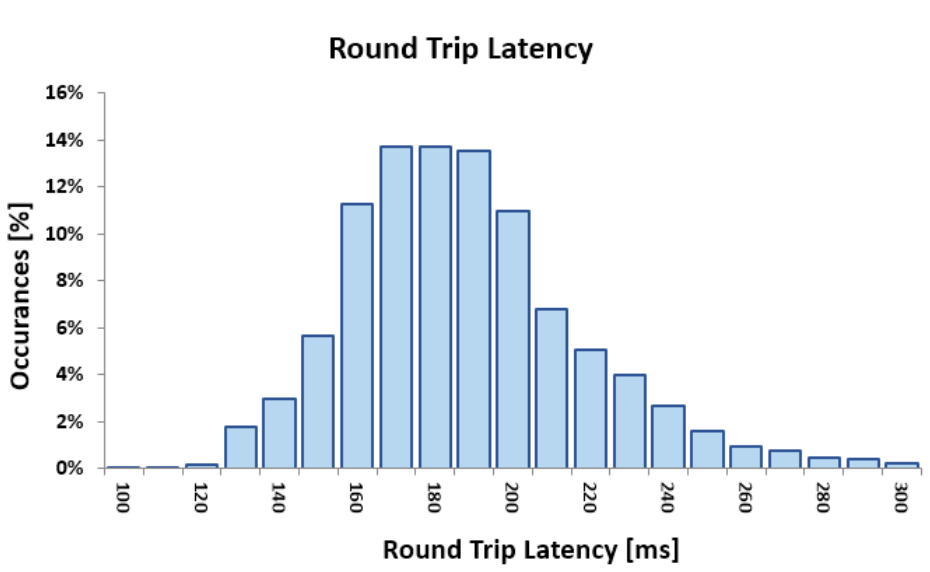
Figure 10. Histogram summarizing the round-trip data latency